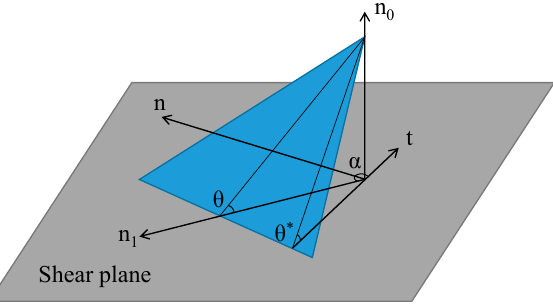
Figure 5. Schematic of the apparent dip angle.